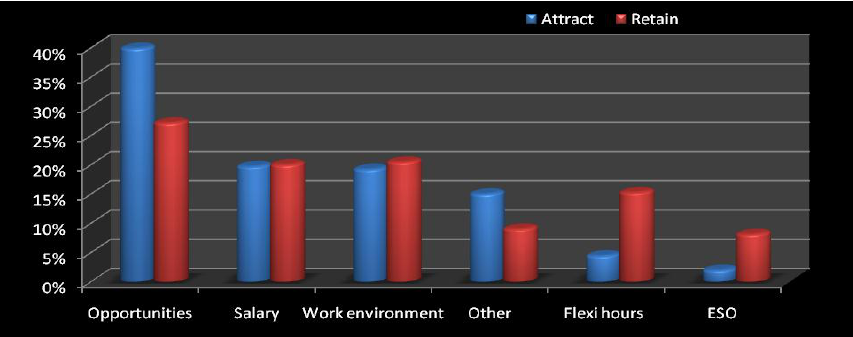
Figure 2: Reward Preferences